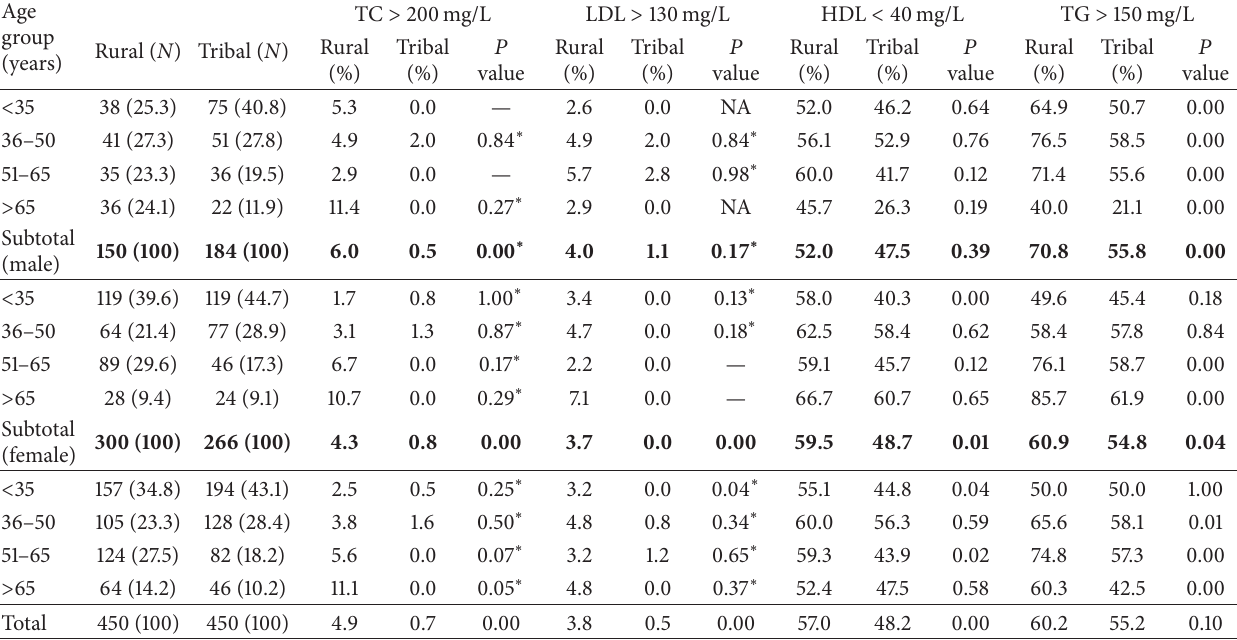
Table 3: Age and sex distribution of lipid profile in rural and tribal area of a Himalayan state, Himachal Pradesh, India, 2010. Age group (years)